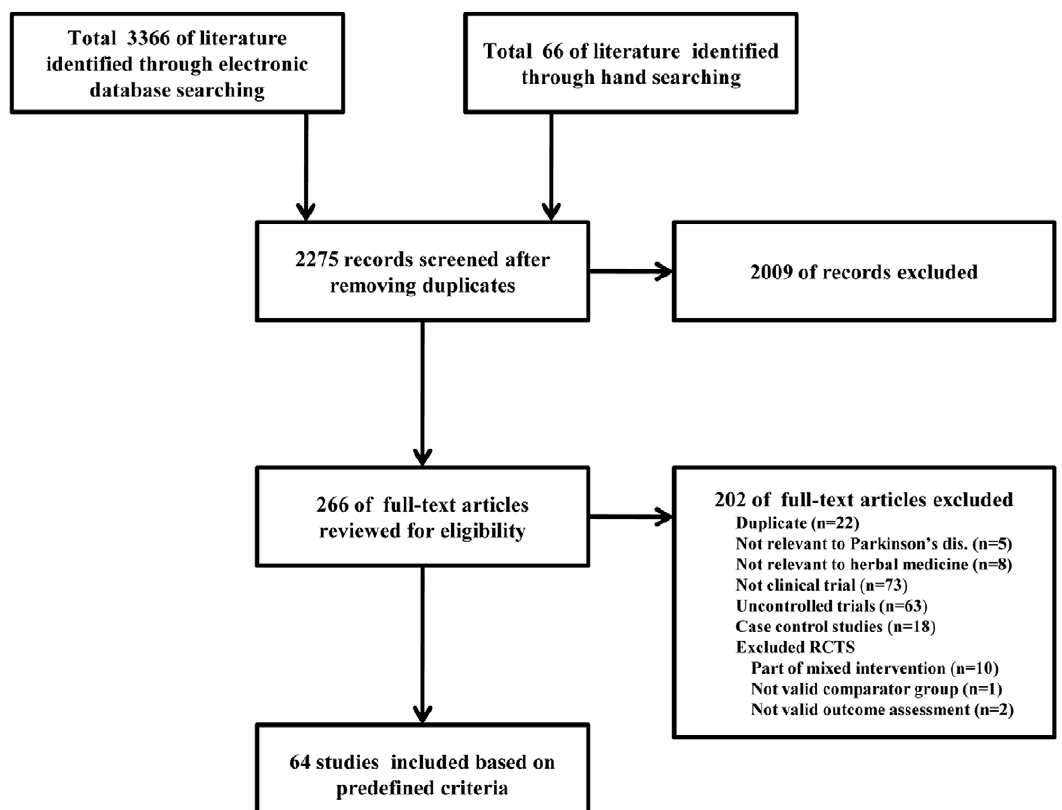
Figure 1. Flow chart of information for this systematic review.